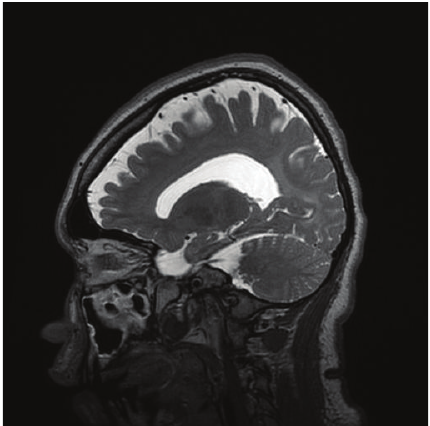
Figure 3: Sagittal MRI view of the brain at the age of 17 showing diffuse increased T2 signal in the subcortical and periventricular white matter demonstrating diffuse leukodystrophy. GE sagittal T2 CUBE image performed on a 3T MR GE scanner with TR: 3000, TE: